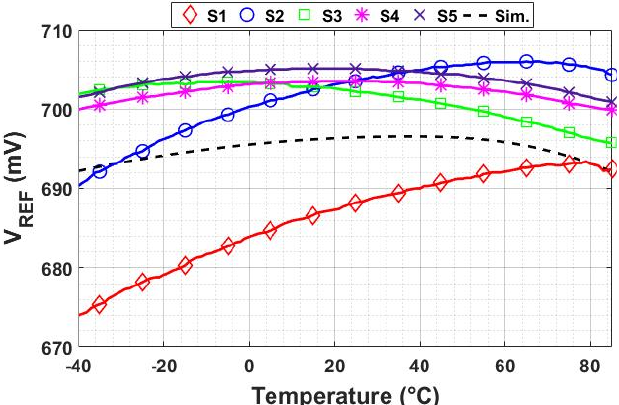
Figure 16. Measured V REF as a function of temperature for five chip samples (untrimmed).